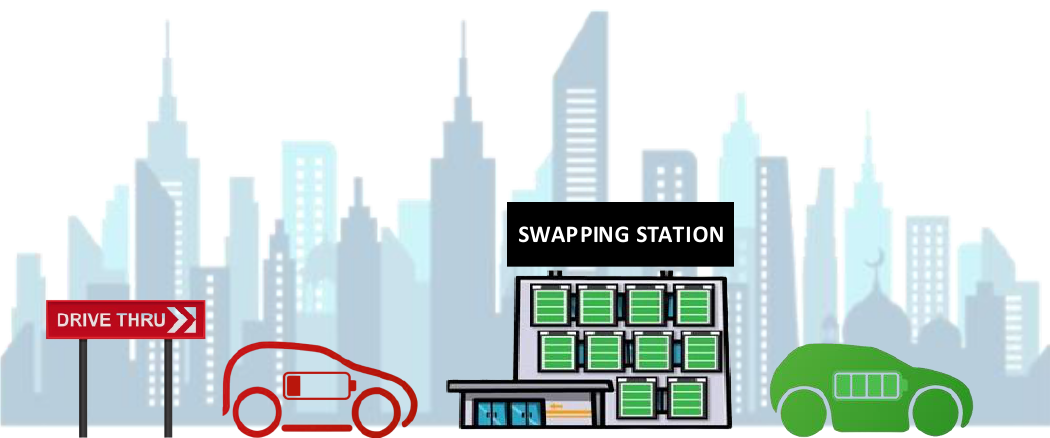
Figure 20. Battery swapping station layout for EV